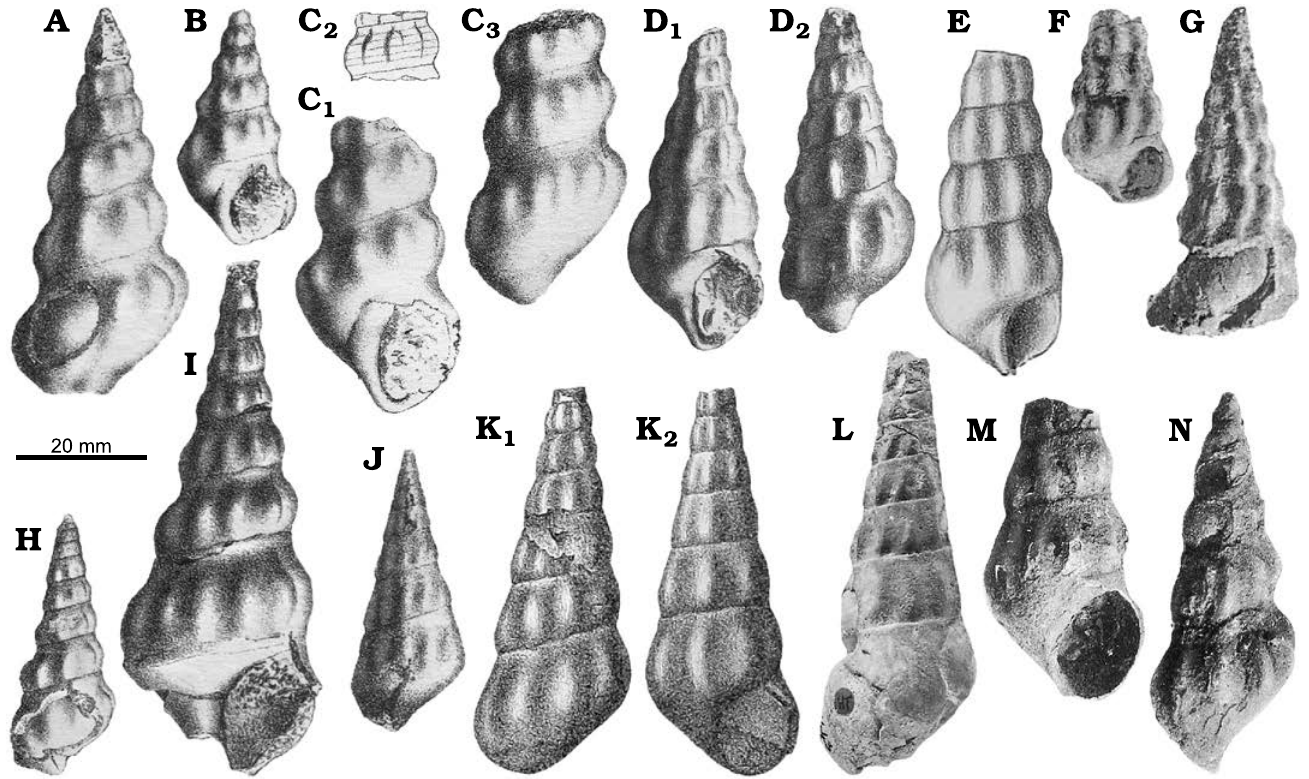
Fig. 6. Original illustrations of the Early Jurassic Zygopleura ­like species probably closely related to Ederazyga . A , B . Chemnitzia moorei Gemmellaro, 1878 (pl. 6: 4, 5), Sinemurian, Rocca Busambra (north­western Sicily, southern Italy). C . Chemnitzia tatia Gemmellaro, 1878 (pl. 6: 1–3), Sinemurian, Rocca Busambra (north­western Sicily, southern Italy), in apertural view (C 1 ), detail showing the spiral ornament (C 2 ), and dorsal view (C 3 ). D . Chemnitzia polyplecta Gemmellaro, 1878 (pl. 6: 7, 8), Sinemurian, Rocca Busambra (north­western Sicily, southern Italy), in apertural (D 1 ) and dorsal (D 2 )